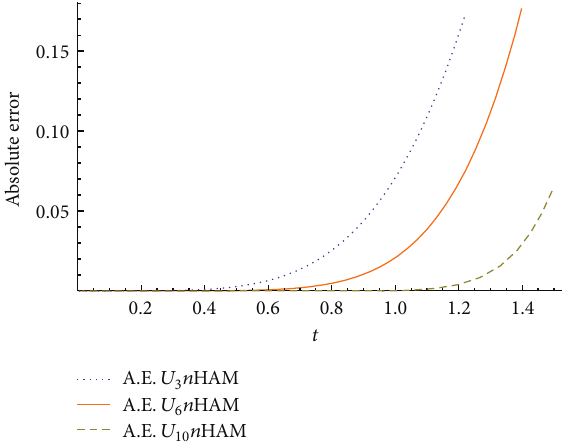
Figure 5: The comparison between the 𝑈 3 , 𝑈 6 , and 𝑈 10 of 𝑛 HAM (m 𝑞 -HAM; 𝑛 = 1) and the exact solution of (28) at ℎ = −1 and 𝑥 = 1 .